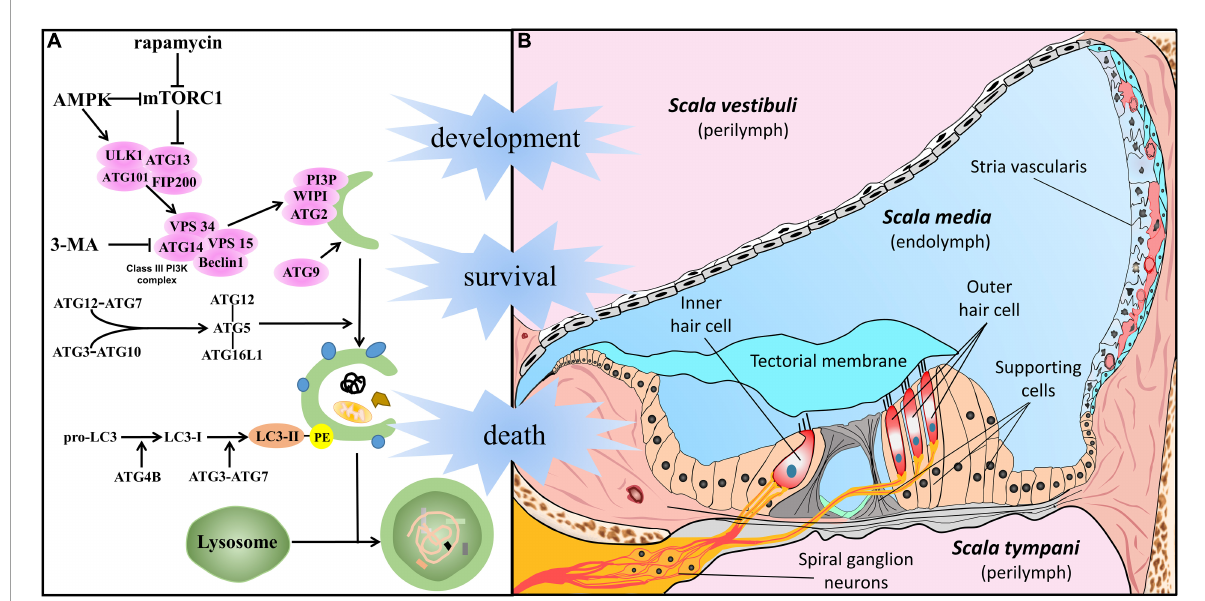
FIGURE1 Autophagy in the cells of the auditory system. (A) In response to cellular stress, autophagy is promoted by AMPK or suppressed by mTORC1 and initiated by the activation of the ATG1/ULK kinase complex. After the assembly of multiprotein complexes (including Beclin1 and VPS34), the class III phosphatidylinositol 3-phosphate complex (PI3KC3) is generated to act in phagophore formation. Membrane sources from organelles and the production of PI3KC3 promote membrane elongation by recruitment of the ATG2–WIPI (ATG18 in yeast) complex. In addition, ATG9 vesicles, the transmembrane core ATG protein, contribute to the membrane supply. Underscoring the importance of the ATG complex, ATG12 conjugates with ATG5 and ATL16L1, and the LC3 subfamily conjugates with PE, resulting in an expanded phagophore engulfing autophagic cargo via autophagy receptors and the completion of double-membrane autophagosomes. Eventually, it gives rise to the maturation of autophagolysosomes and degradation following fusion with lysosomes. (B) Structure of the cochlea, especially meticulous cells in the scala media, filled with endolymph. The crucial part of auditory perception, hair cells (including IHC and OHC), are located on the basilar membrane and surrounded by epithelia-supporting cells in the Organ of Corti. Sensory HCs make synaptic connections with SGNs whose dendrites form connections with the cochlear nucleus. The stria vascularis lies on the lateral wall, and work with supporting cells plays an important role in cochlear homeostasis and acoustic